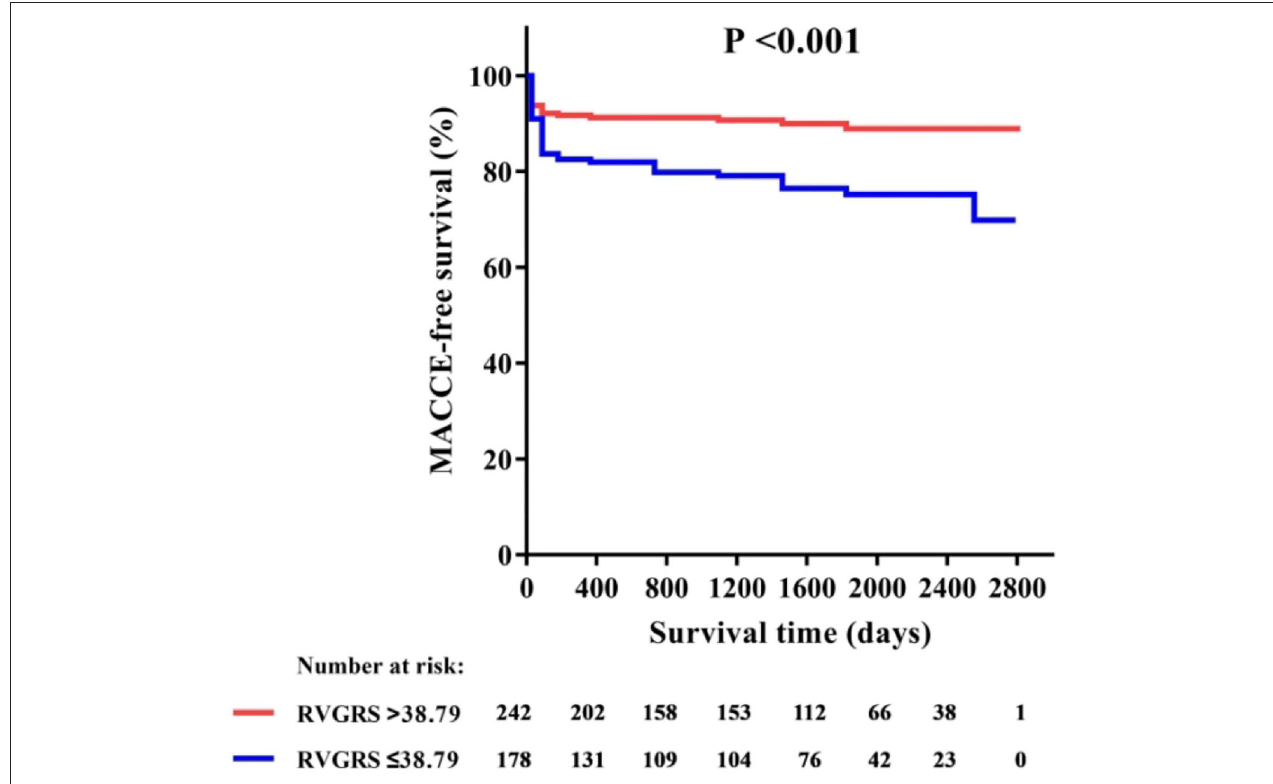
FIGURE 4 | Kaplan-Meier curve of MACCE-free survival in patients with or without RV-GRS impairment. GRS, global radial strain; MACCE, major adverse cardiac and cerebrovascular events.